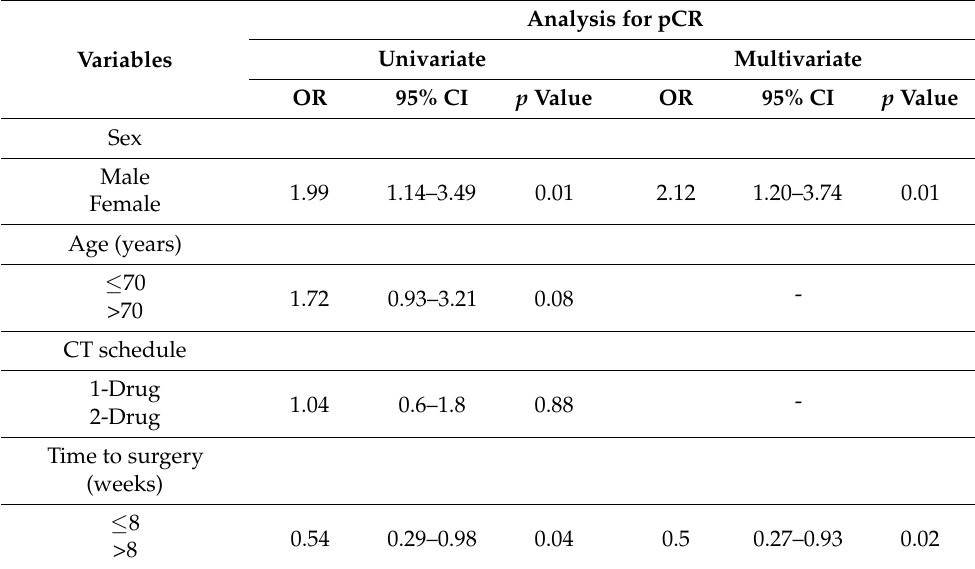
Table 5. Results of univariate and multivariate analysis for pCR.